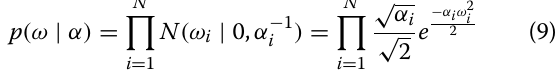
In order to tackle that problem, SBL adds a constraint to the weight that the parameter ω obeys a Gaussian distri- bution with its mean value equals 0. With such